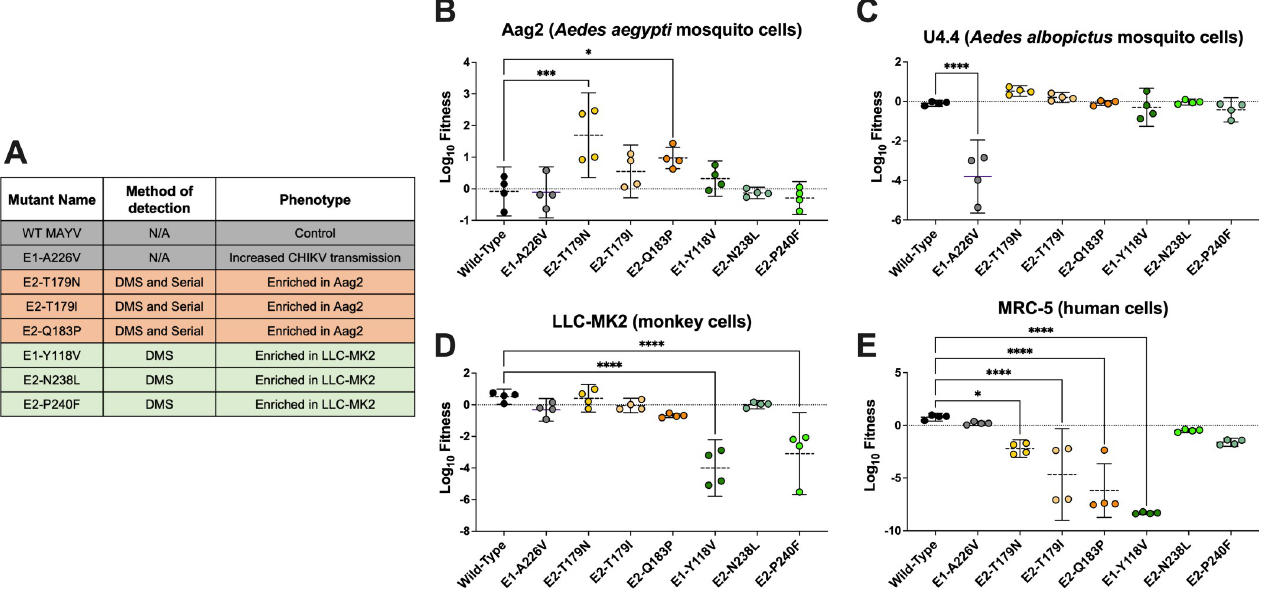
Fig 2. Variants enriched in an Ae . aegypti cell line ( Aag2) have increased fitness in Aag2 cells but decreased fitness in a human cell line (MRC-5). A: List of the viruses used for the competition assays. The method (serial passaging or DMS) used to identify the mutations, as well as the phenotypes observed for these different viruses are indicated. B-E: Competition assays in mosquito (Aag2 and U4.4) and mammalian (LLC-MK2 and MRC-5) cell lines: Aag2 ( B ), U4.4 ( C ), LLC-MK2 ( D ), and MRC-5 ( E ) cells. Cells were infected at an MOI of 0.01 using a 1:1 ratio based on PFUs for each mutant or WT with a genetically marked MAYV competitor virus. Viral supernatants were harvested at 72h post-infection for Aag2 and 48h post-infection for the other cell lines. Replication of WT and mutant viruses was assessed by RT-qPCR using specific probes labeled with different fluorophores. Log 10 fitness was calculated by normalizing replication of each virus against a genetically marked reference virus. The mean of 4 independent experiments is represented with standard deviation. Statistical analysis: * = p < 0.05; ** = p < 0.01; *** = p < 0.001; **** = p < 0.0001 (one-way ANOVA with Dunnett’s correction). “Serial” refers to the serial passaging natural evolution experiments to find adaptive